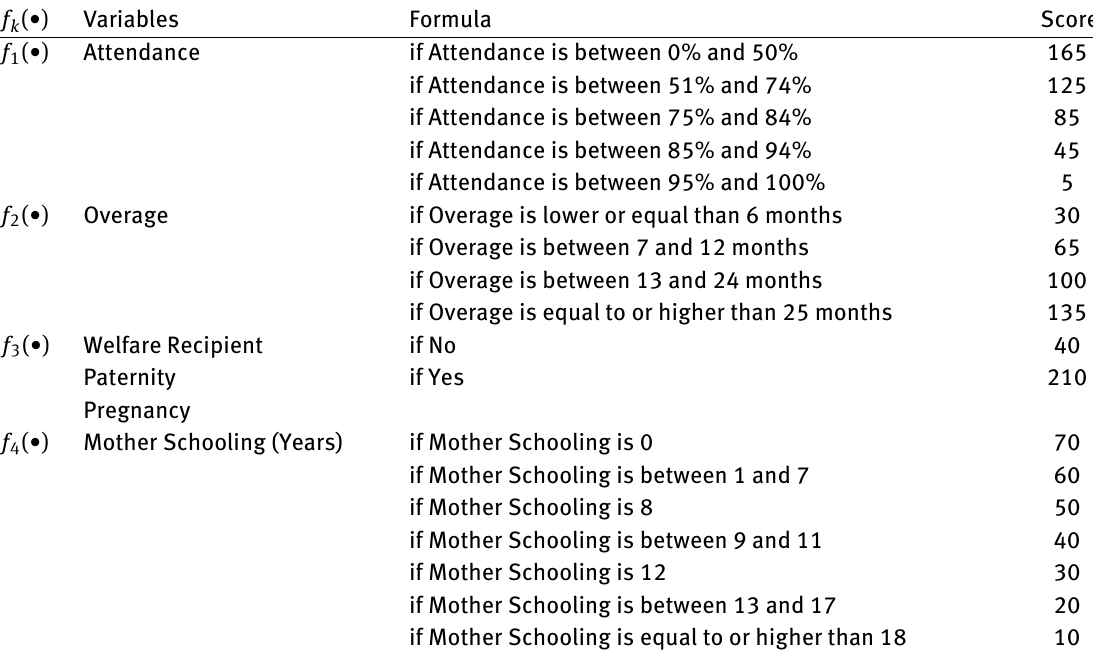
Table 2: Functions f k (•) Transforming IVSE Variables into